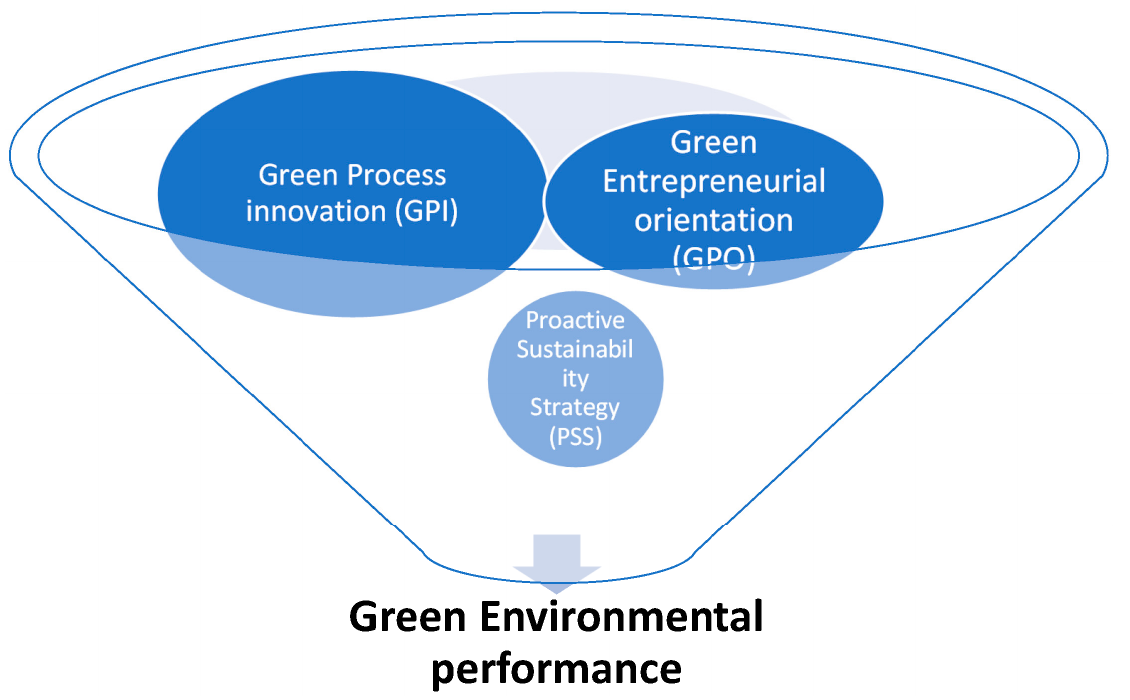
Figure 1. Conceptual Framework of the Study.